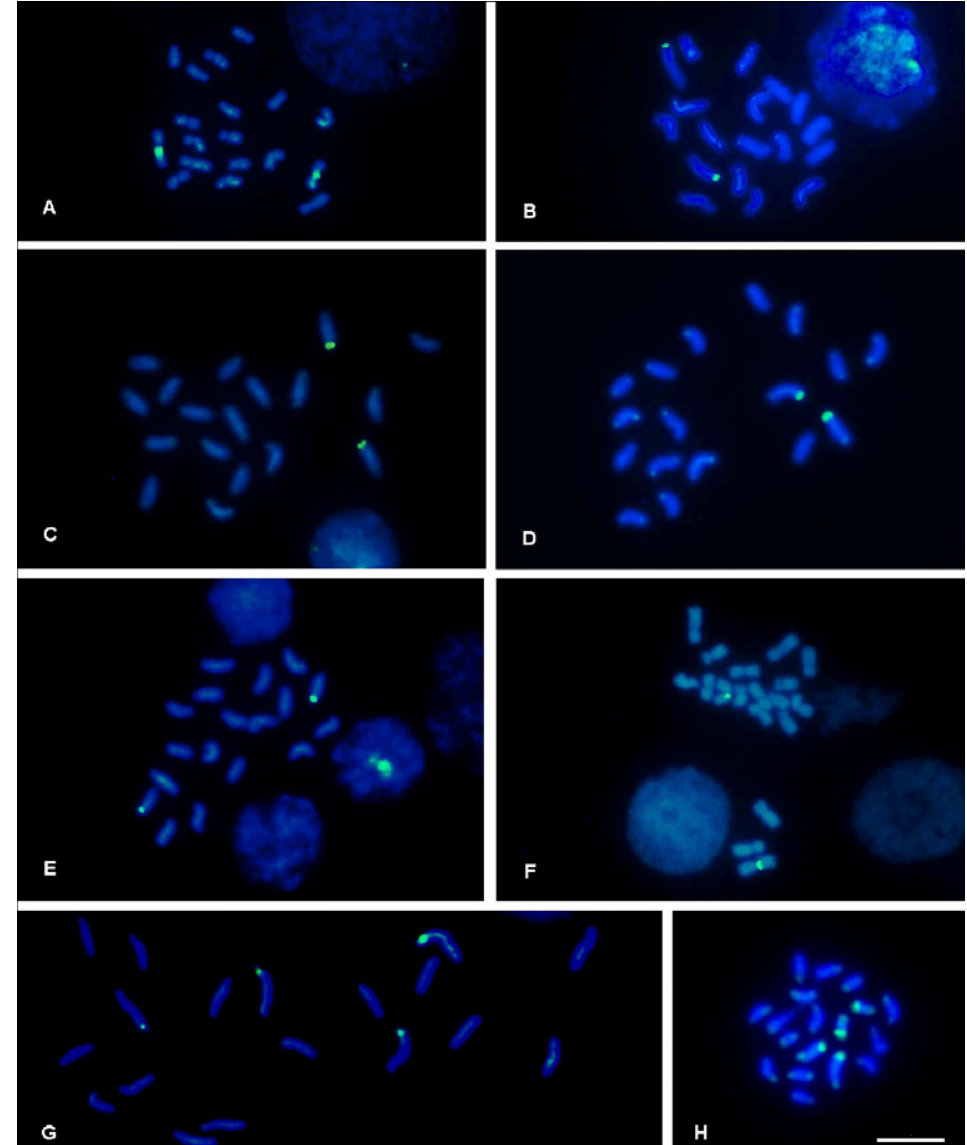
/DAPI staining in metaphases of Melipona quadrifasciata (A), Melipona. aff. flavolineata (Xapuri-AC) Fig 3 . CMA 3 (B), M. aff. flavolineata (Brasiléia-AC) (C), M. aff. flavolineata (Xapuri-AC) (D), M. aff. flavolineata (Capixaba-AC) (E), Melipona bicolor (F), Melipona crinita (G) and Melipona nebulosa (H). CMA 3+ (Green bands). Bar = 10